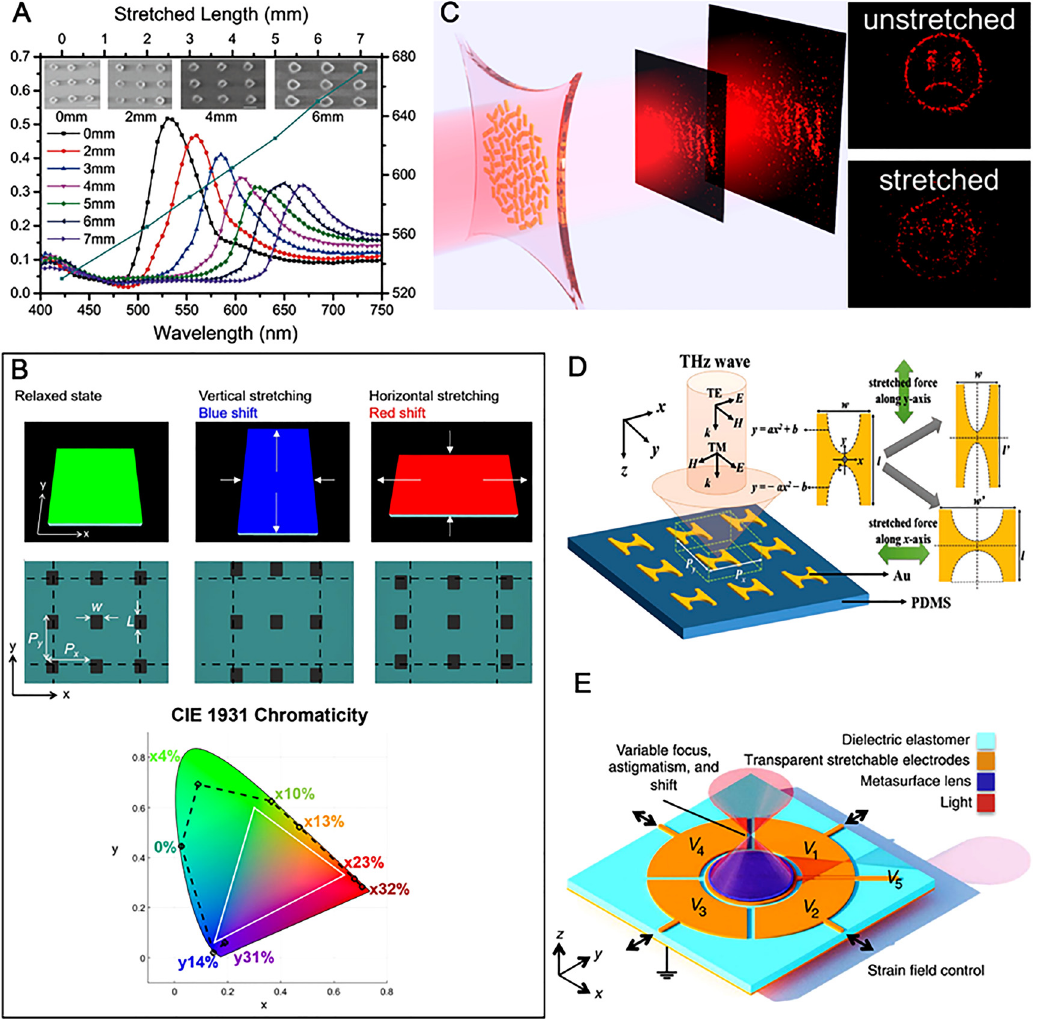
Figure 5: Structures and applications of tunable metasurfaces created on flexible stretchable